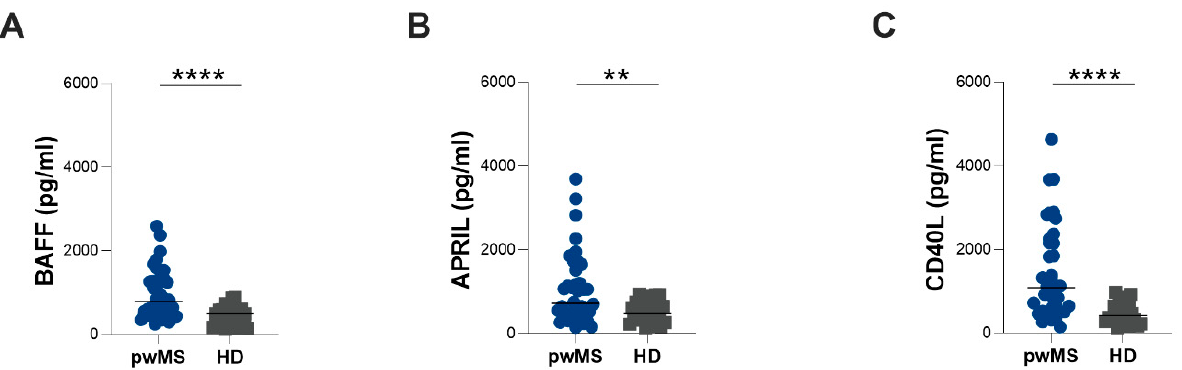
Figure 2. Baseline evaluation of plasma BAFF, APRIL and CD40L levels in pwMS. ( A ) Comparison of plasma BAFF levels between pwMS compared to HD. ( B ) Comparison of plasma APRIL levels in pwMS compared to HD. ( C ) Comparison of plasma CD40L levels at T0 in pwMS compared to HD. The non-parametric comparative Mann–Whitney test was used to compare medians between pwMS and HD. BAFF: B-cell-activating factor; APRIL: a proliferation-inducing ligand; CD40L: CD40 ligand; pwMS: people with MS; HD: healthy donors. **: p < 0.01; ****: p < 0.0001. Table 2. Longitudinal evaluation of plasma BAFF, APRIL and CD40L levels in pwMS and comparison HD. pwMS HD T0 T6 T12 p § p † p †† p †††